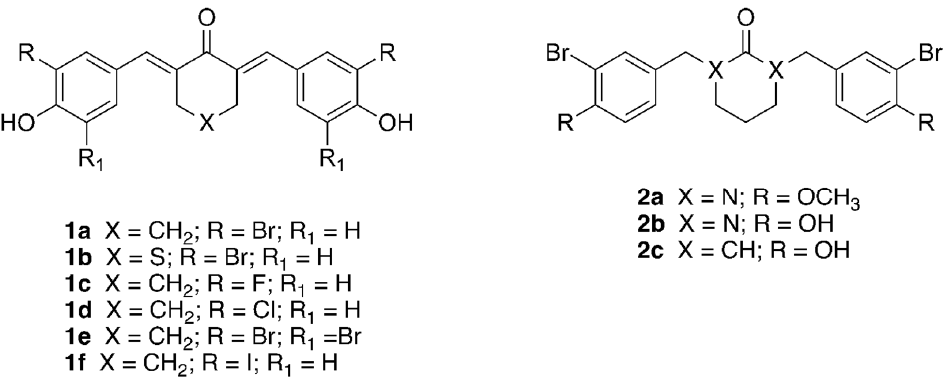
Figure 1. Structures of the cinnamoyl compounds 1a – f and of the saturated derivatives 2a – c .